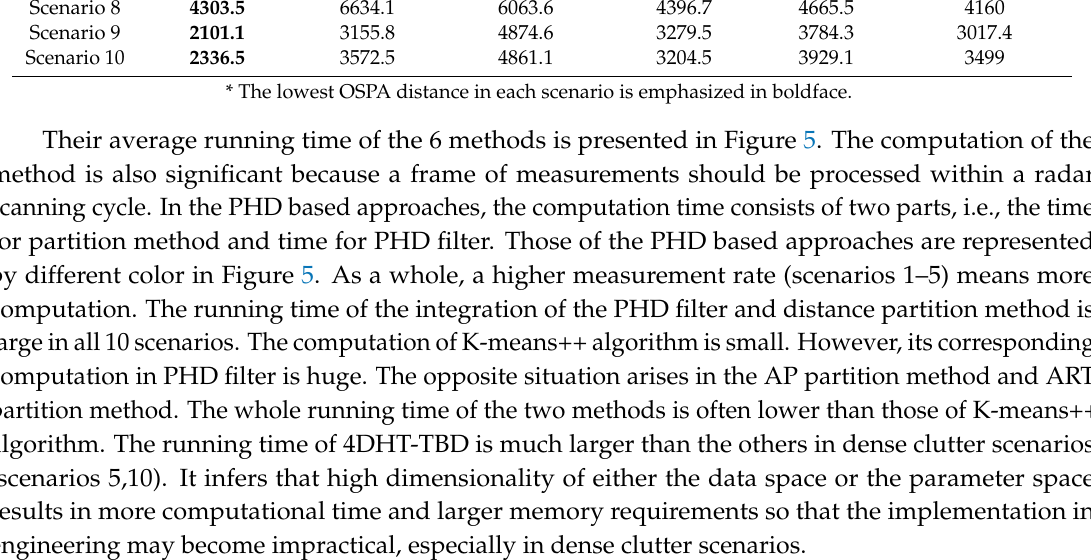
Table 2. The average the optimal sub-pattern assignment (OSPA) distance of the algorithms in 10 scenarios.